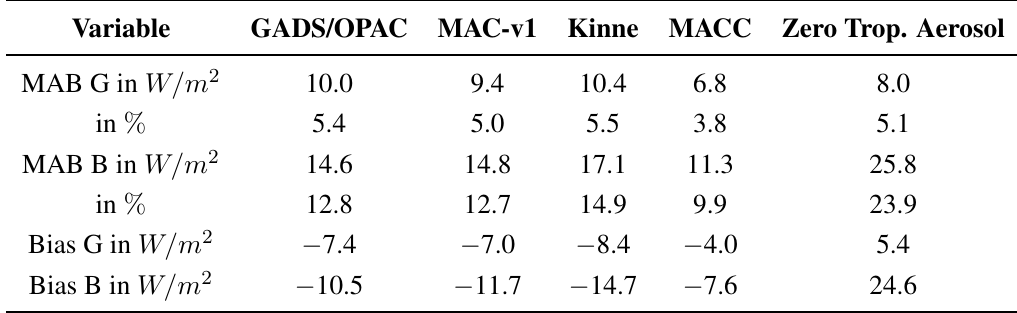
Table 2. Mean Absolute Bias (MAB) over all stations for global irradiance G and direct (beam) irradiance B in absolute units W/m 2 and relative units % MAB deviation relative to the mean. The last two lines provide the bias in W/m 2 . The last column provides the results for the assumption of zero tropospheric aerosol